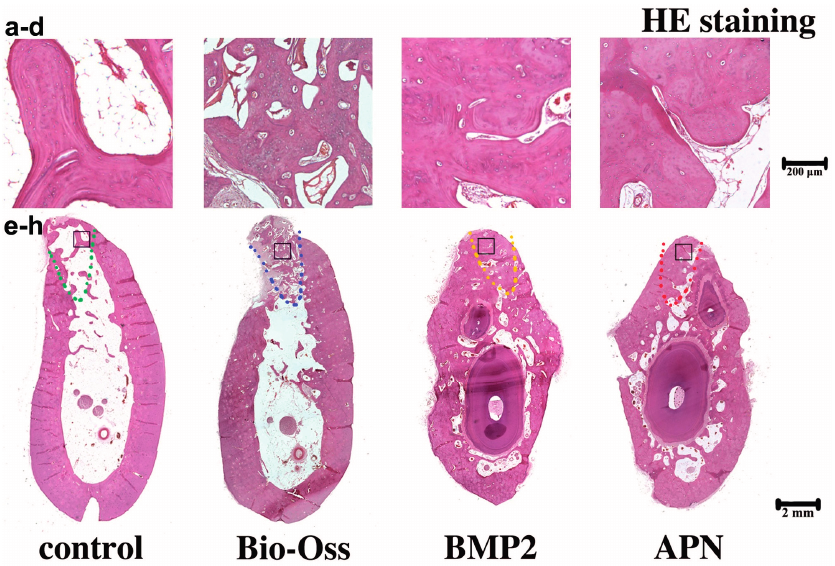
Figure 3. Decalcified H&E staining of the extraction sockets following the different 12-week treatments: ( a )The magnifying control group; ( b ) Bio-Oss group; ( c ) BMP2 group; ( d ) APN group; ( e – h ) represent the integral extraction socket of control group ( e ); Bio-Oss group ( f ); BMP2 group ( g ); APN group ( h ). The black square represents the magnifying area. The dashed line represents the extraction sockets. Magnification: upper panel 40×; lower panel 4×. n = 4 for each group.